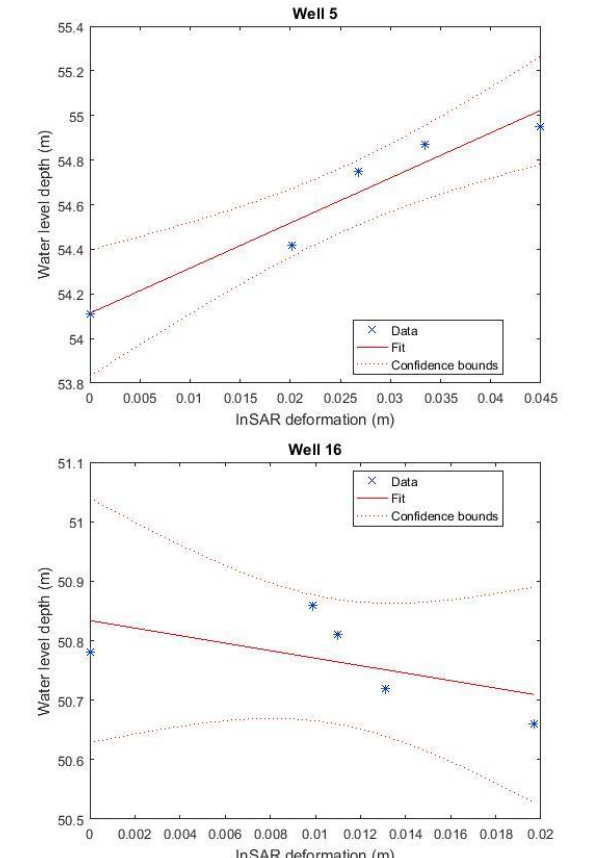
Figure 7. Water level changes of aquifer at piezometric wells located in different parts of the subsidence area. Figure 6. Fractures in the Sirjan plain as consequences of In order to quantify the relationship between groundwater level subsidence. fluctuations and ground surface subsidence, we showed both of them in a unique plot for some of piezometric wells in Figure 8. As it is shown, the values of water level spanning between Oct 2004 and Mar 2005 are plotted on the y -axis and InSAR deformation time-series representing ground subsidence are plotted on the x -axis. Values shown on x -axis are over the span of measuring water level depth in piezometric wells, roughly. As shown in the figure, red solid line is a linear regression fitted to the plotted points. The inverse slop of solid line can be considered as an approximate of skeletal storage coefficient at the well location (Hoffmann,